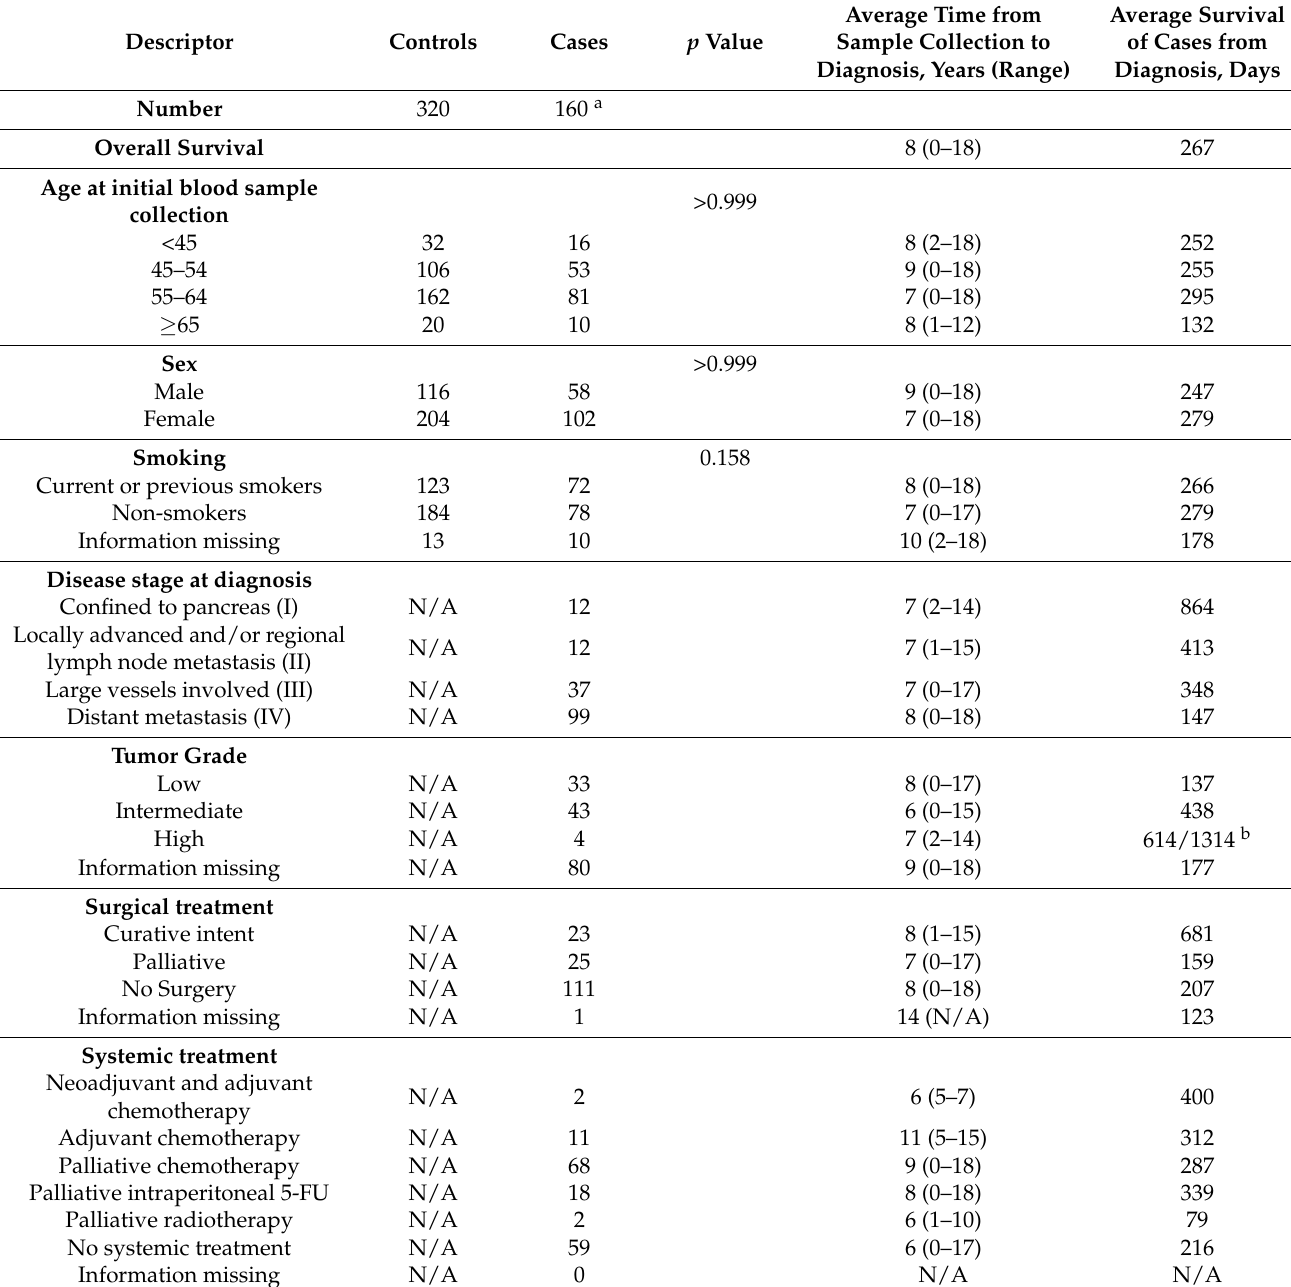
Table 1. Description of the patient and control cohort from the Northern Sweden Health and Disease